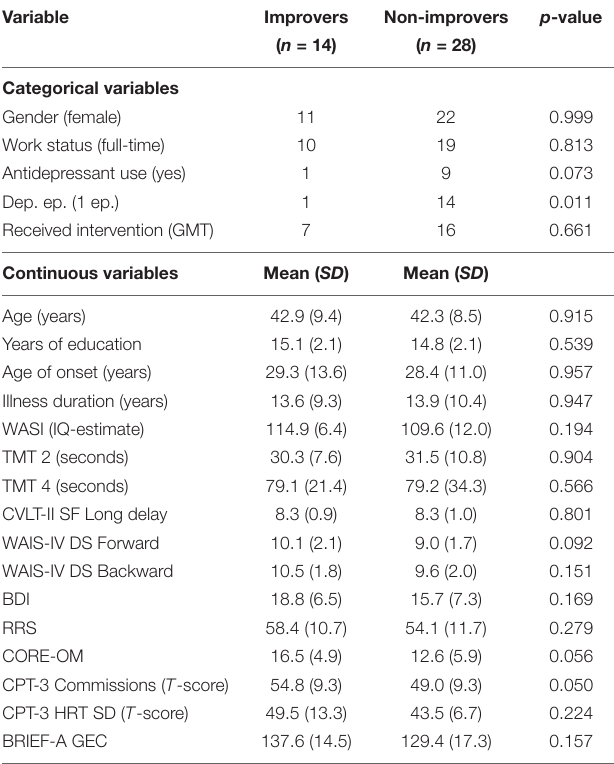
TABLE 4 | Characteristics of improvers and non-improvers in